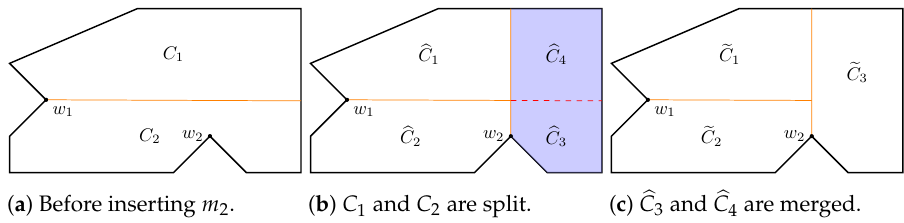
Figure 5. Updating the cell structure of the motorcycle graph.